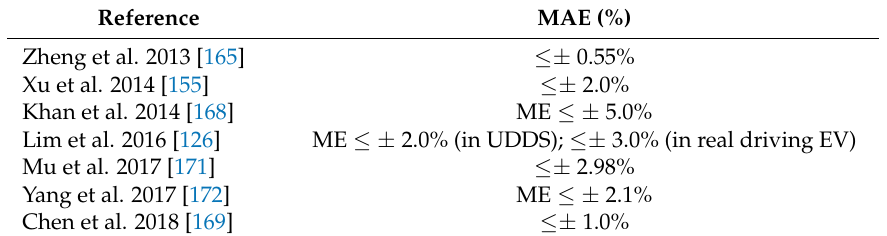
Table 16. MAE/ME of the GA, variants of the GA and hybrid GA-based SOC estimation